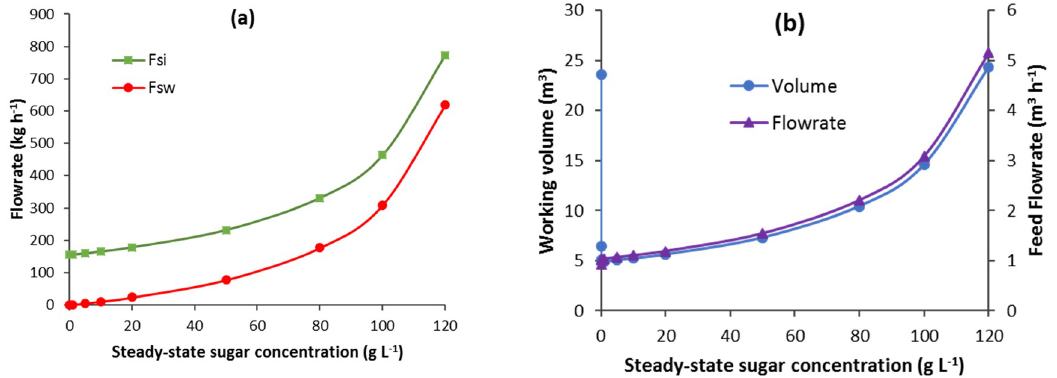
Figure 2. Effect of CSTB steady-state sugar concentration on ( a ) mass flowrates of feed and wasted sugar, and ( b ) bioreactor working volume and feed flowrate [steady-state oxygen concentration is 2 mg·L −1 ].